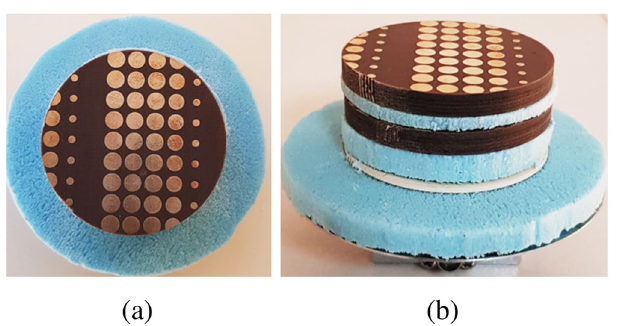
Figure 19. Second antenna measurement assembly of RCA and lower PGM ( a ) Top view and ( b ) side